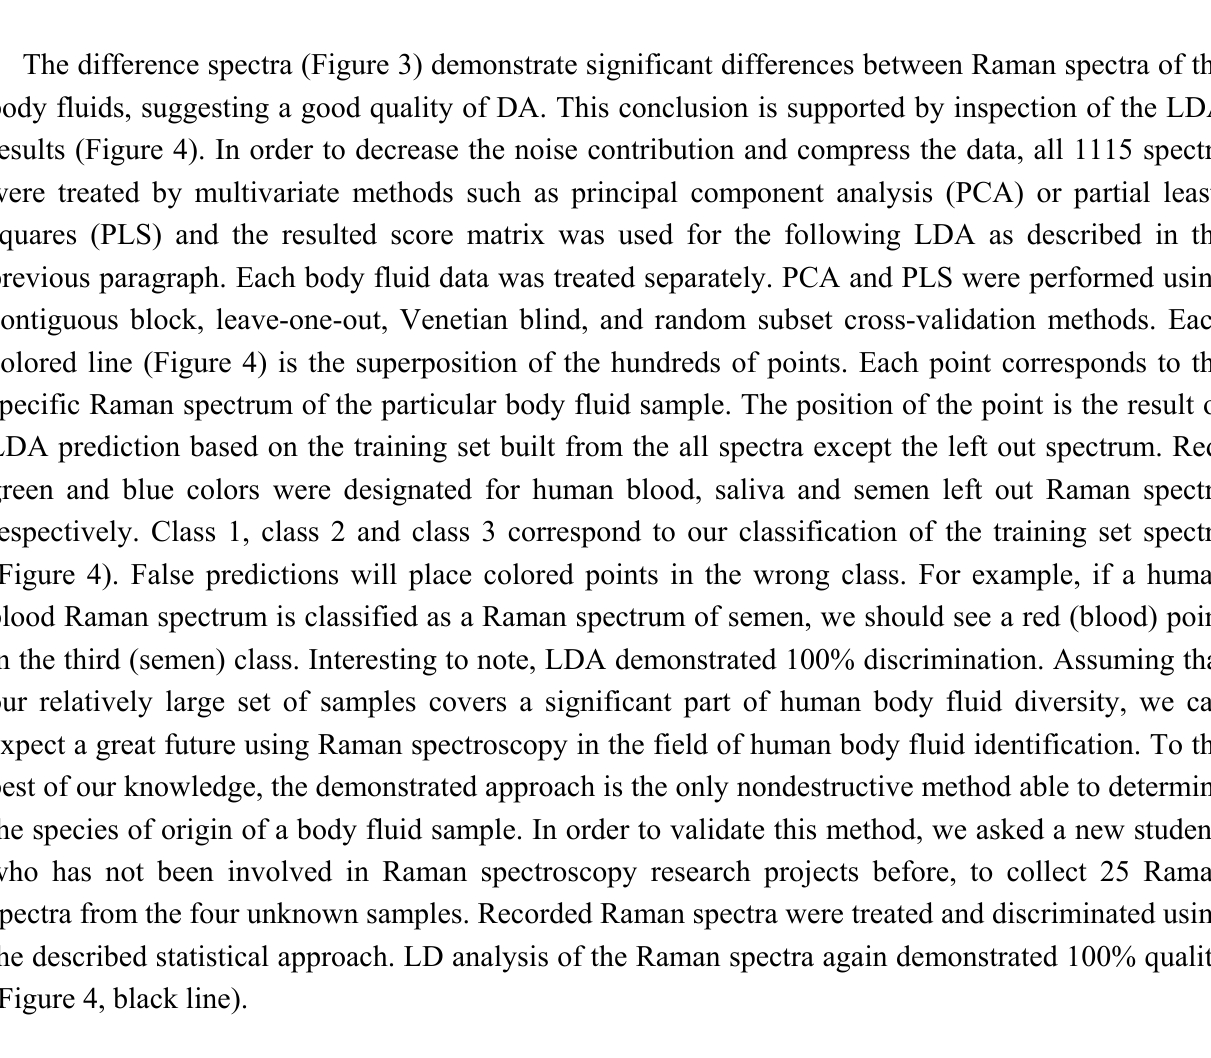
Figure 3. Difference between the average Raman spectrum of all human body fluids ( black ) and averaged Raman spectra of human blood ( red ), semen ( blue ) and saliva ( green ). Spectra are scaled for